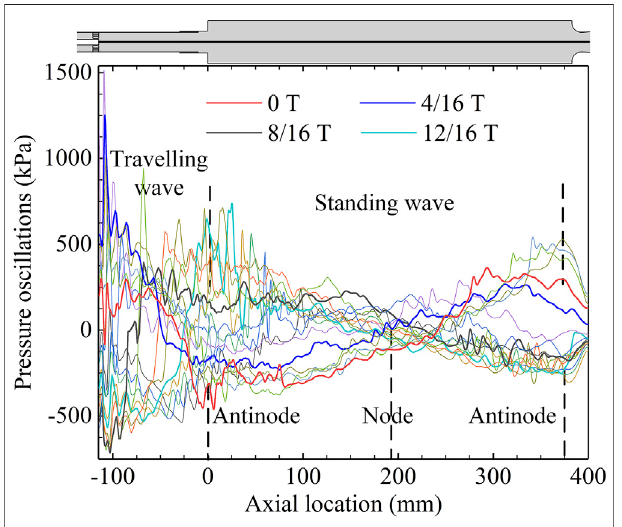
FIGURE 7 | Pressure mode shapes in the model combustor. Oscillating pressure of the centerline (the black line on the top of the plot) over an entire cycle. Only four instantaneous pressure waves are highlighted.